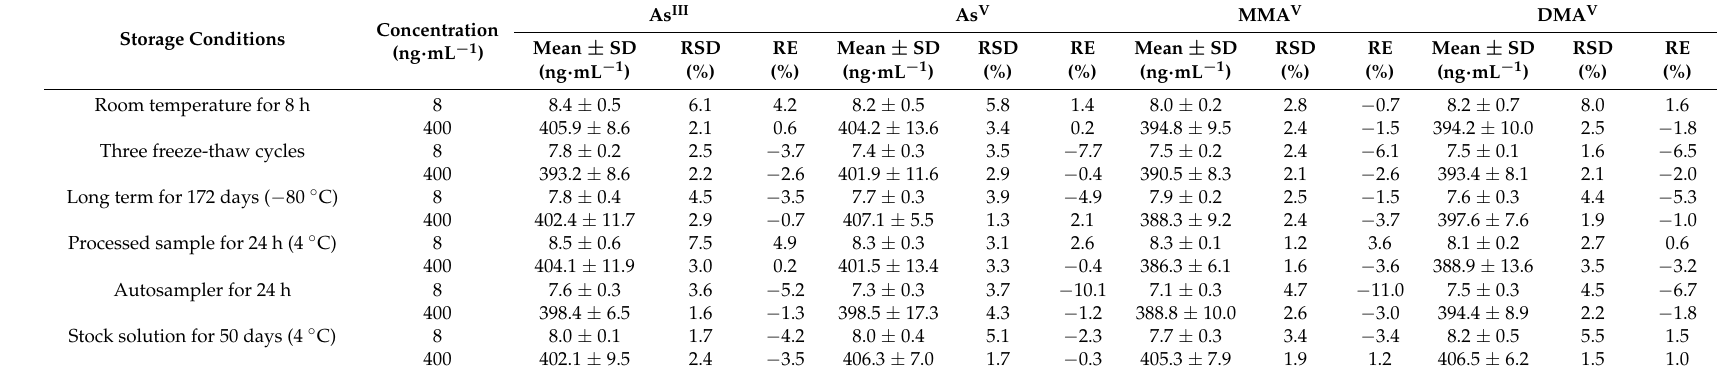
Table 3. Stability data of the four arsenicals in cynomolgus macaque plasma under different storage conditions ( n = 6).